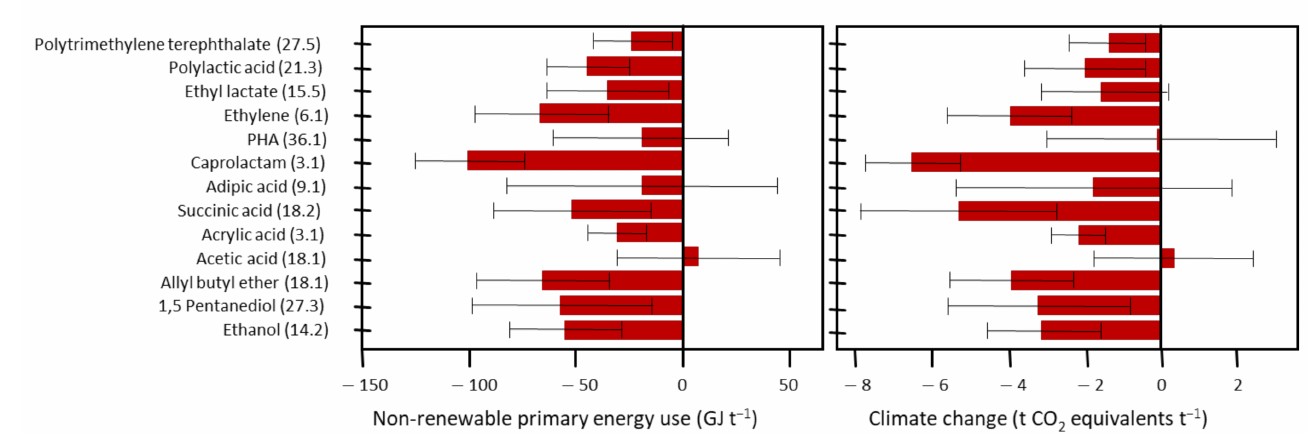
Figure 4. Average non-renewable primary energy use and GHG emissions of bio-based chemicals in comparison to conventional chemicals [40]. Numbers in parentheses indicate the sample size for the bio-based and conventional chemicals,